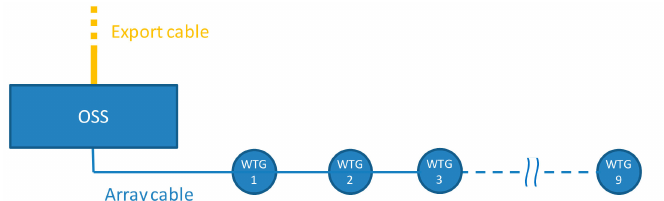
Figure 7. The layout of the array cable strings, each string consist of a total of nine wind turbine generators (WTGs). DAC test was performed from the o ff shore substation (OSS).